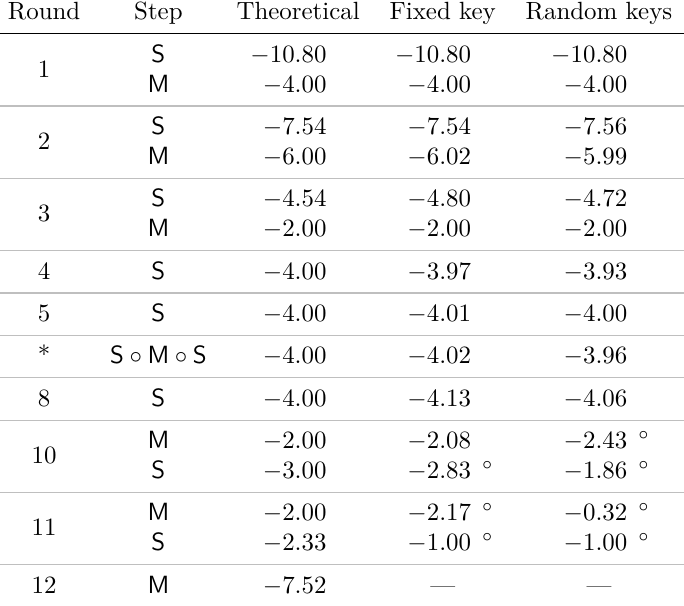
Table 3: Experimental verification of estimated probabilities p f . Marks ‘ ◦ ’ indicate a low sample size ( < 10). Empty values ‘—’ indicate that no valid pairs were found for this step. Round Step Theoretical Fixed